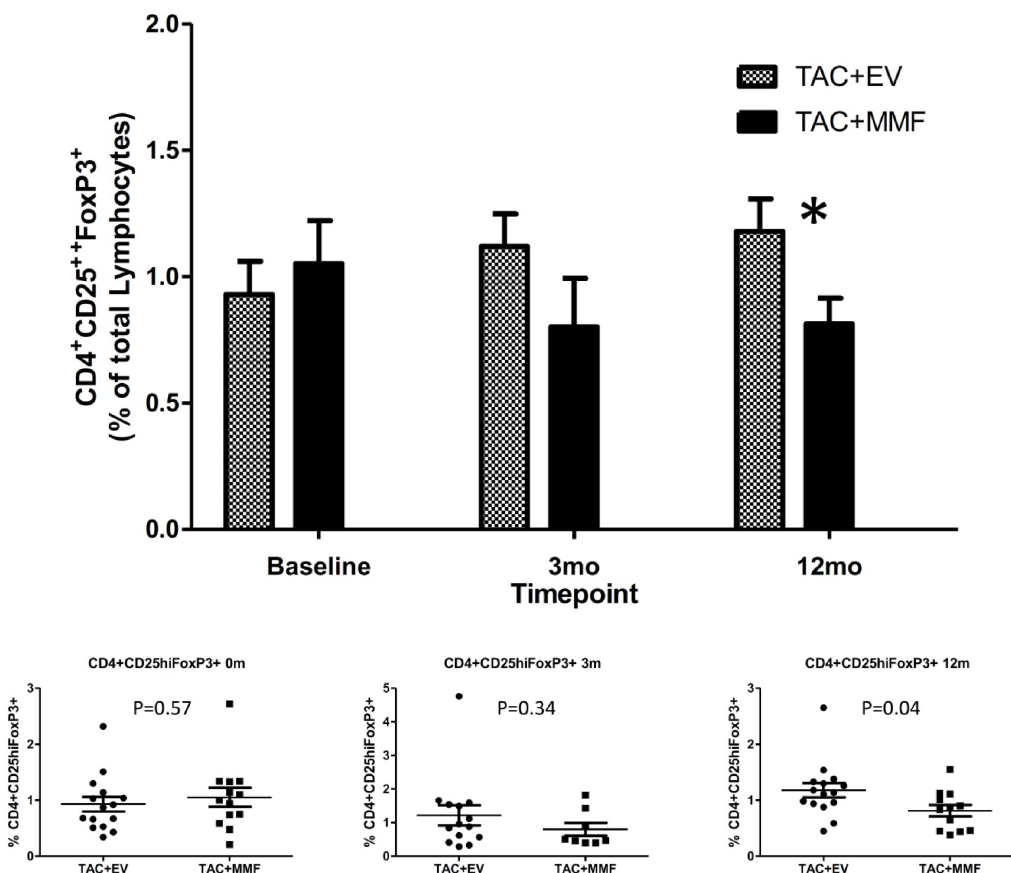
Fig 4. Percentage of CD4 + CD25 hi FOXP3 + regulatory T cells in the peripheral blood between study groups. Flow cytometric analyses were performed as described in Materials and methods. The number of subjects analyzed at—Baseline: TAC+EVR N = 15,TAC+MMF N = 13; 3 mo: TAC+EVR N = 14,TAC+MMF N = 9; 12 mo: TAC+EVR N = 15,TAC+MMF N = 12. Please see Table C in S5 File for complete